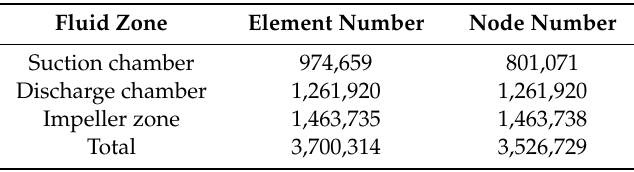
Table 3. Mesh information for calculation